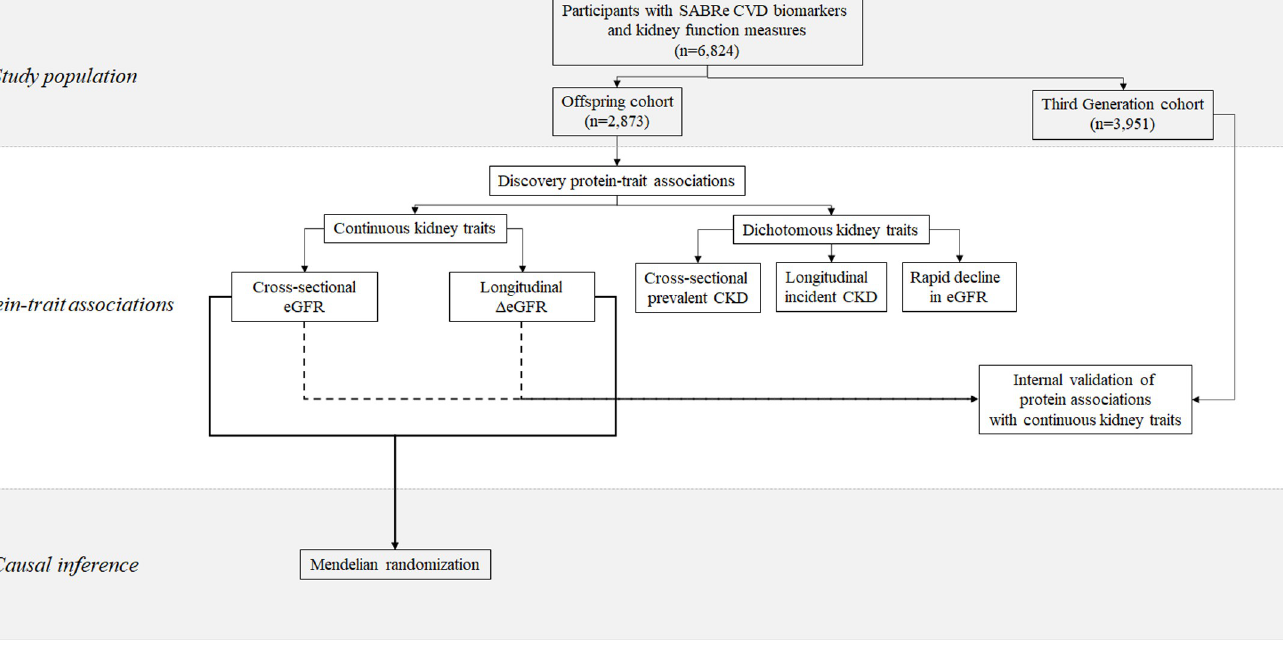
Fig 1. Overview of the study